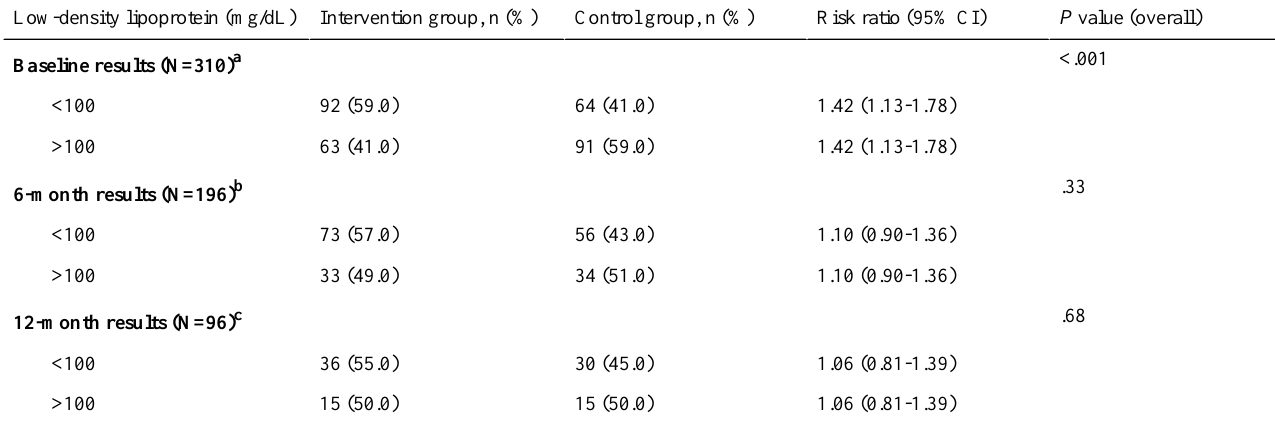
Table 5. Low-density lipoprotein.